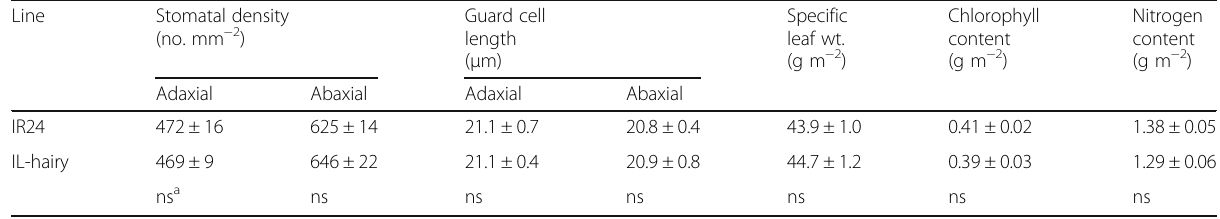
IL-hairy ns a ns ns ns ns Data are means±SD ( n =3 – 4). a ns, not significant by Student ’ s t -test at P